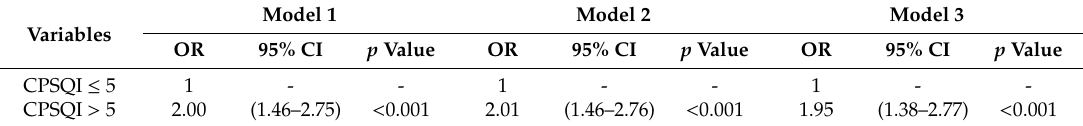
Table 3. Association between sleep quality and frailty status by multiple logistic regression analysis.